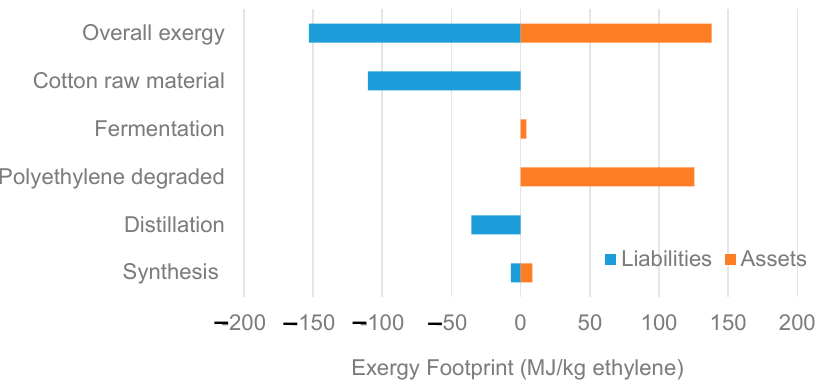
Figure 5. GHG emissions for the linear pattern versus chemical recycling.